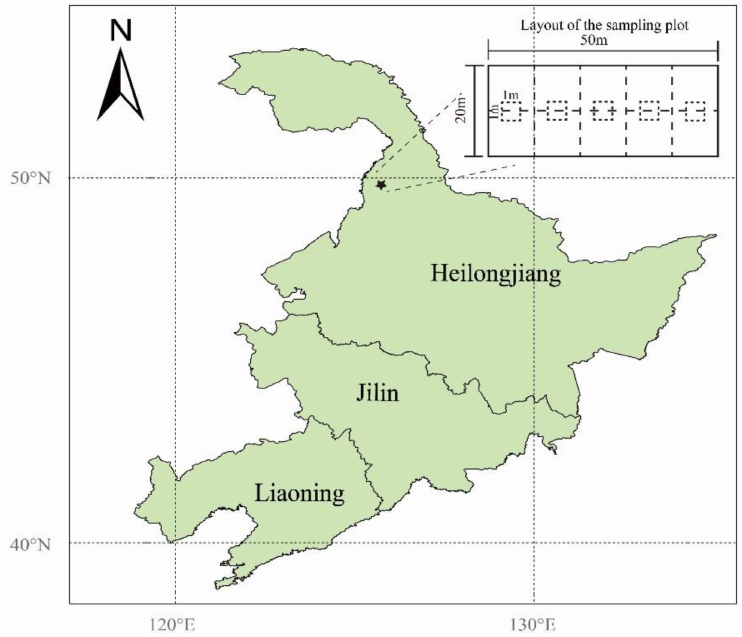
Figure 1. Location of the study site in China, and the layout of the sampling